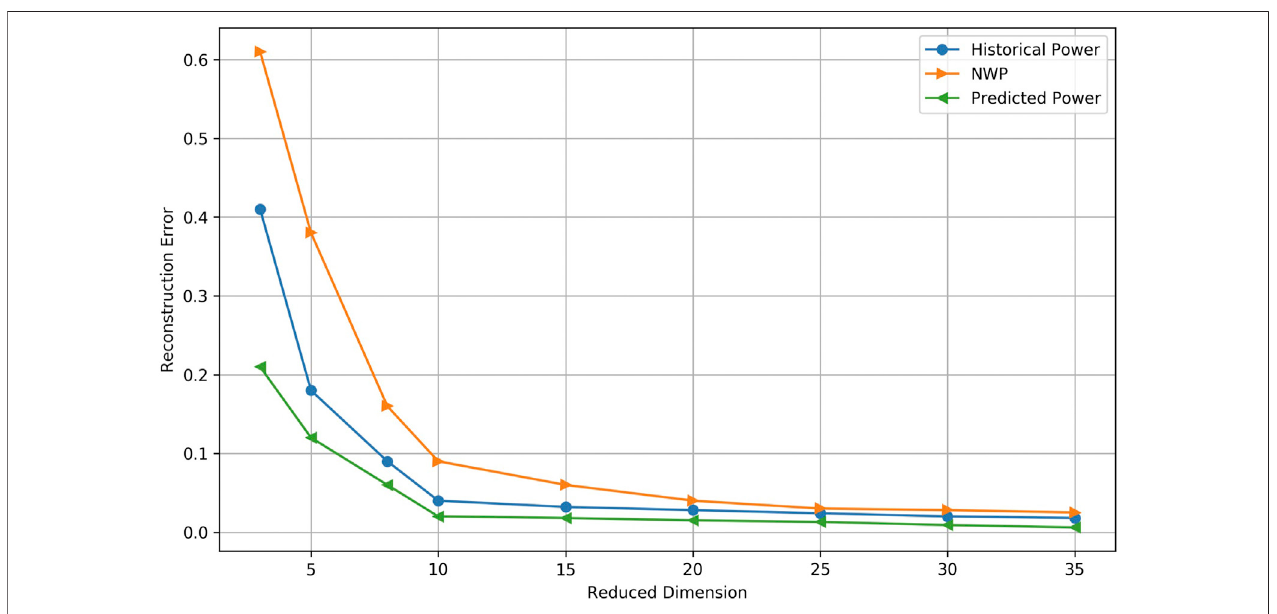
FIGURE 6 | The construction error of different dimension.